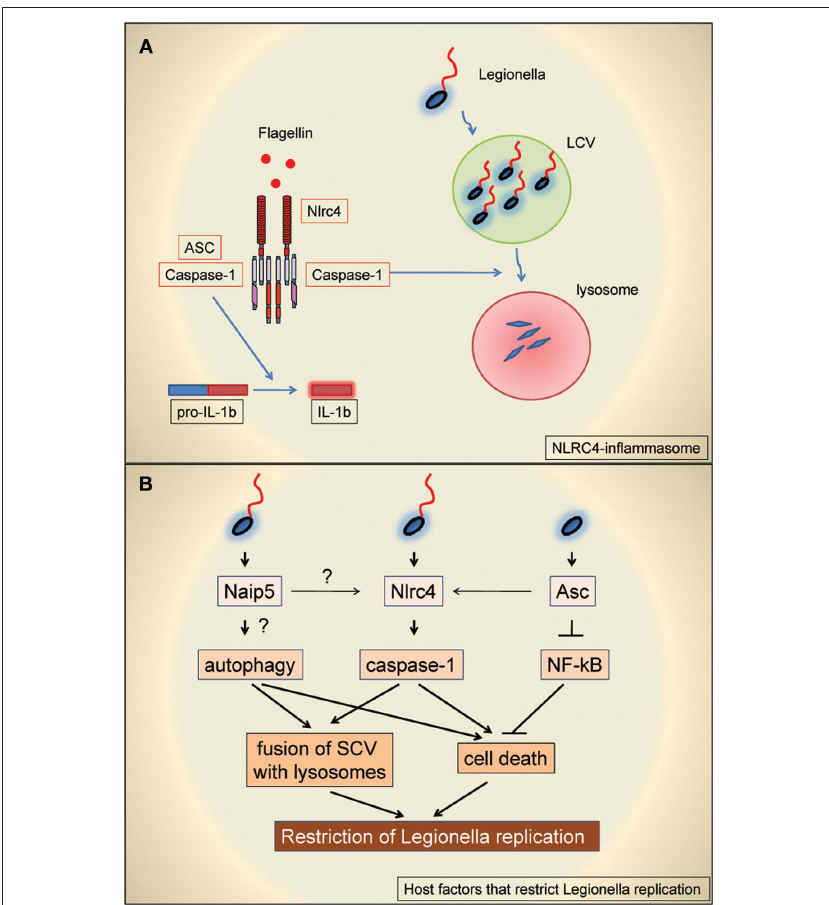
Figure 1 | (A) Schematic representation of the proposed function of NLRC4, ASC, and caspase-1 in the regulation of L. pneumophila replication in macrophages. The NLRC4–ASC–caspase-1 inflammasome promotes the maturation of pro-IL-1 β whereas NLRC4-caspase-1 promotes the fusion of Legionella- containing vacuoles (LCV) with lysosomes, leading to bacterial degradation. Note that in this model ASC is required for the maturation of IL-1 β but is not necessary to promote LCV fusion with lysosomes. (B) Schematic representation of host proteins involved in restricting Legionella replication in non- permissive mouse macrophages and their proposed mode of action. See text for